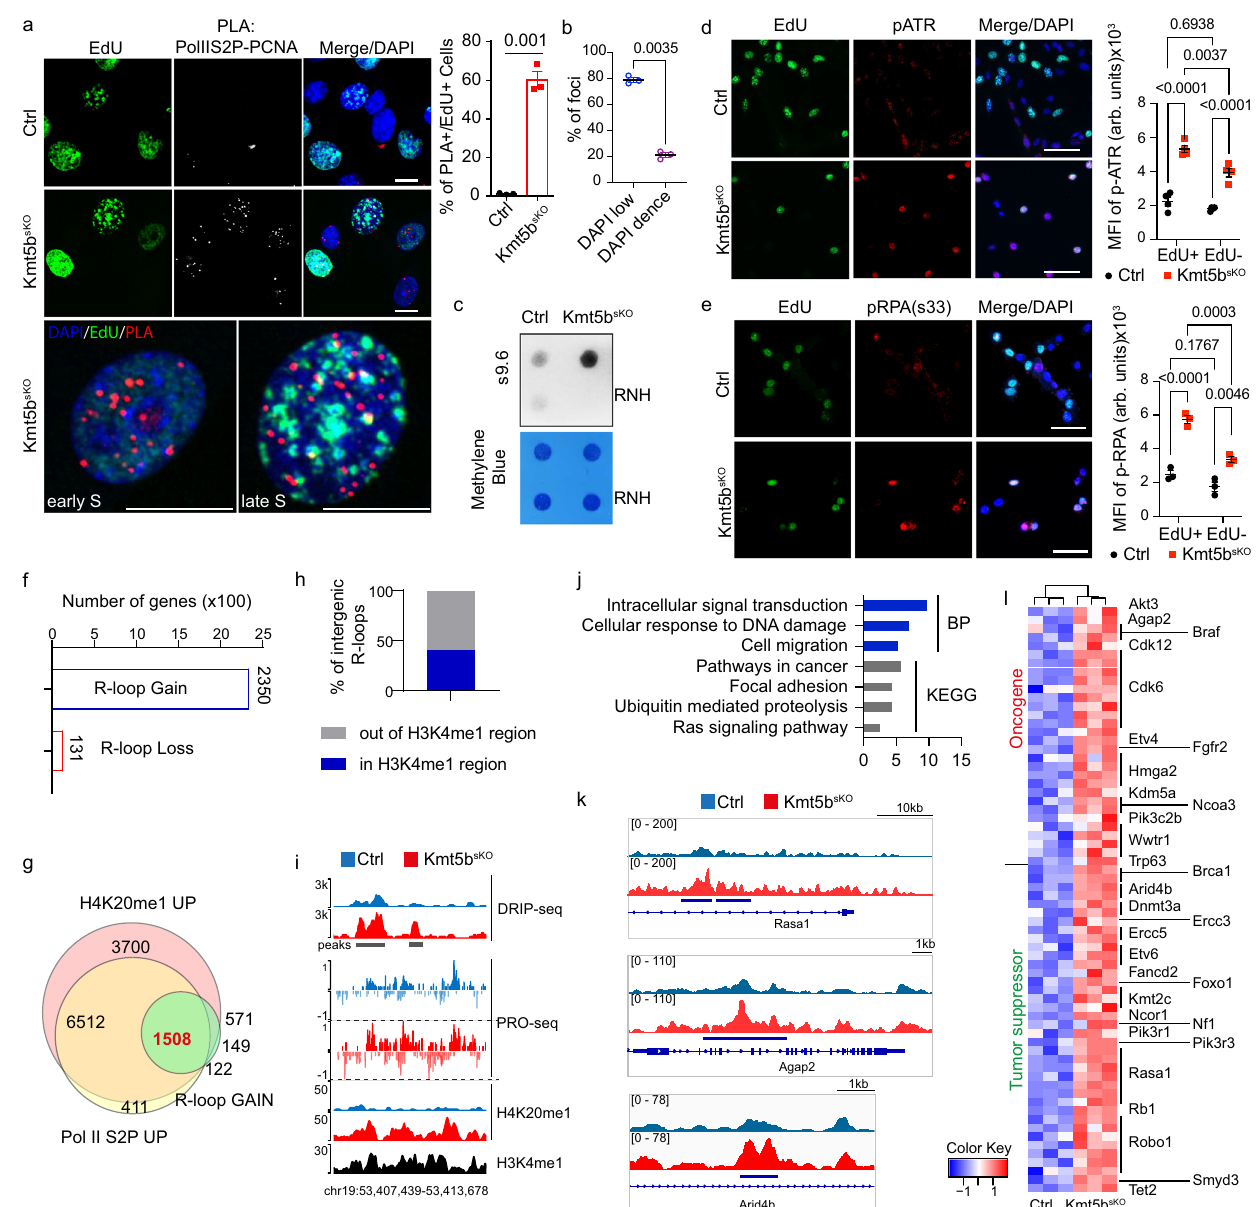
Fig.4|ElevatedtranscriptionalactivityduringS-phaseincreasestranscription- replication collisions and enhances R-loop formation in Kmt5b sKO